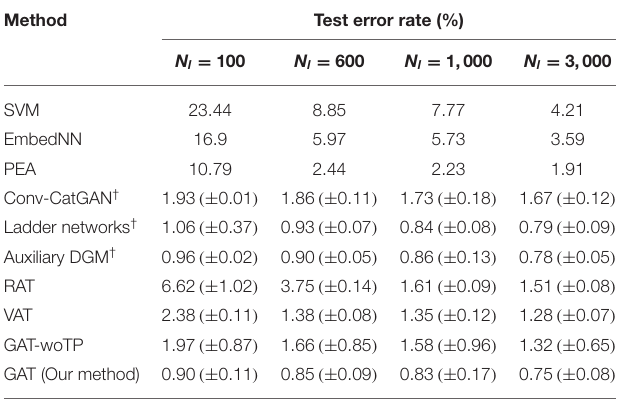
TABLE 2 | Test error rates of semi-supervised learning methods on MNIST datasets.